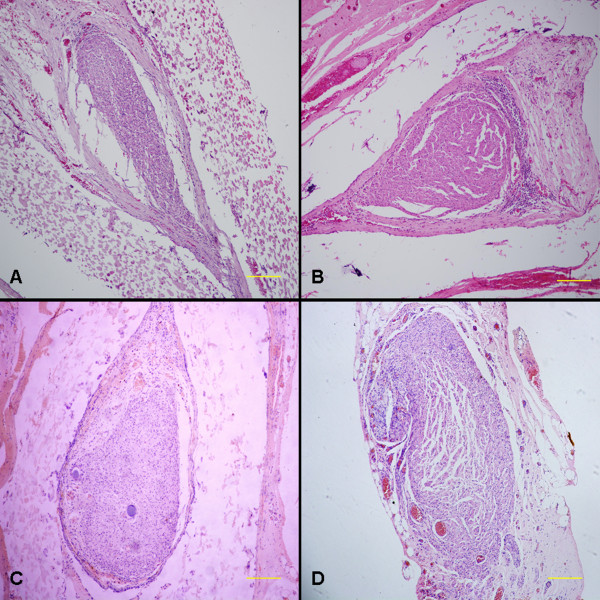
Hematoxylin/eosin staining of the regenerated nerves in different groups at 3 months after surgery. Scale Bar: 200μm. A: group PLGL, B: group PLGL-RGD, C: group PLGL-RGD-NGF, D: group autograft.